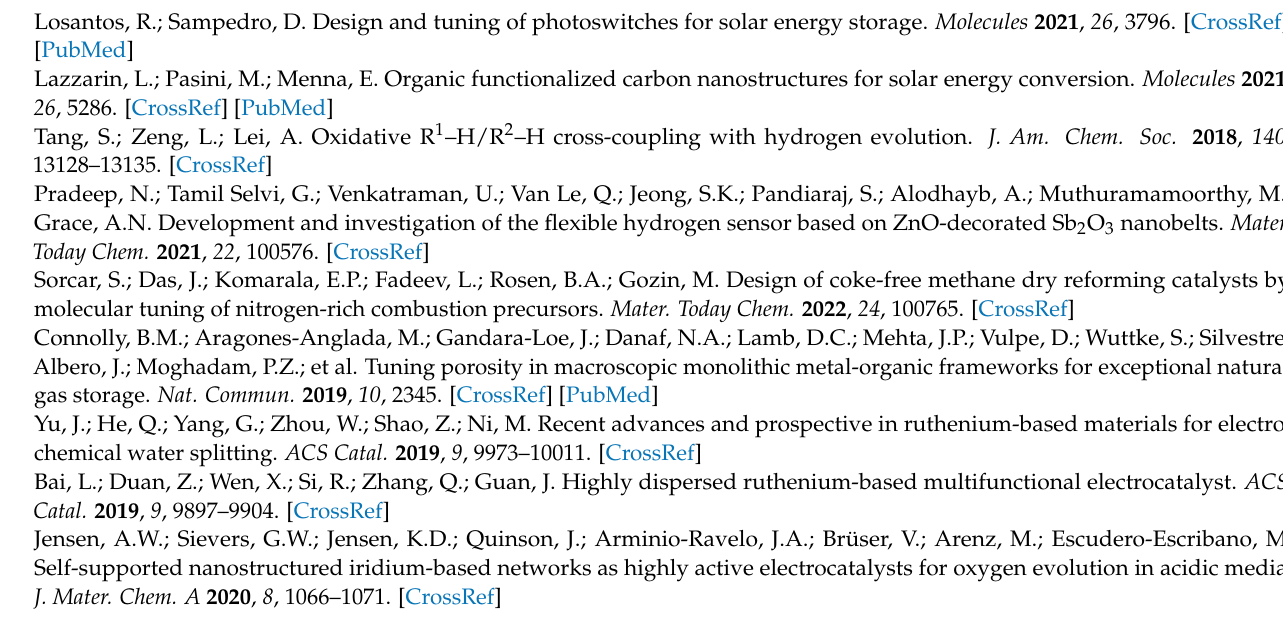
BET specific surface area plot of COF–TB; Figure S2: BET specific surface area plot of Pt@COF–TB; Figure S3: BET specific surface area plot of POM–Pt@COF–TB; Figure S4: BET specific surface area plot of Co 0.75 Fe 0.25 @COF–TB; Figure S5: FT-IR spectra of POM, COF–TB, Pt@COF-TB, POM-Pt@COF– TB and Co 0.75 Fe 0.25 @COF–TB; Figure S6: TEM of Co 0.75 Fe 0.25 @COF–TB; Figure S7: EDS